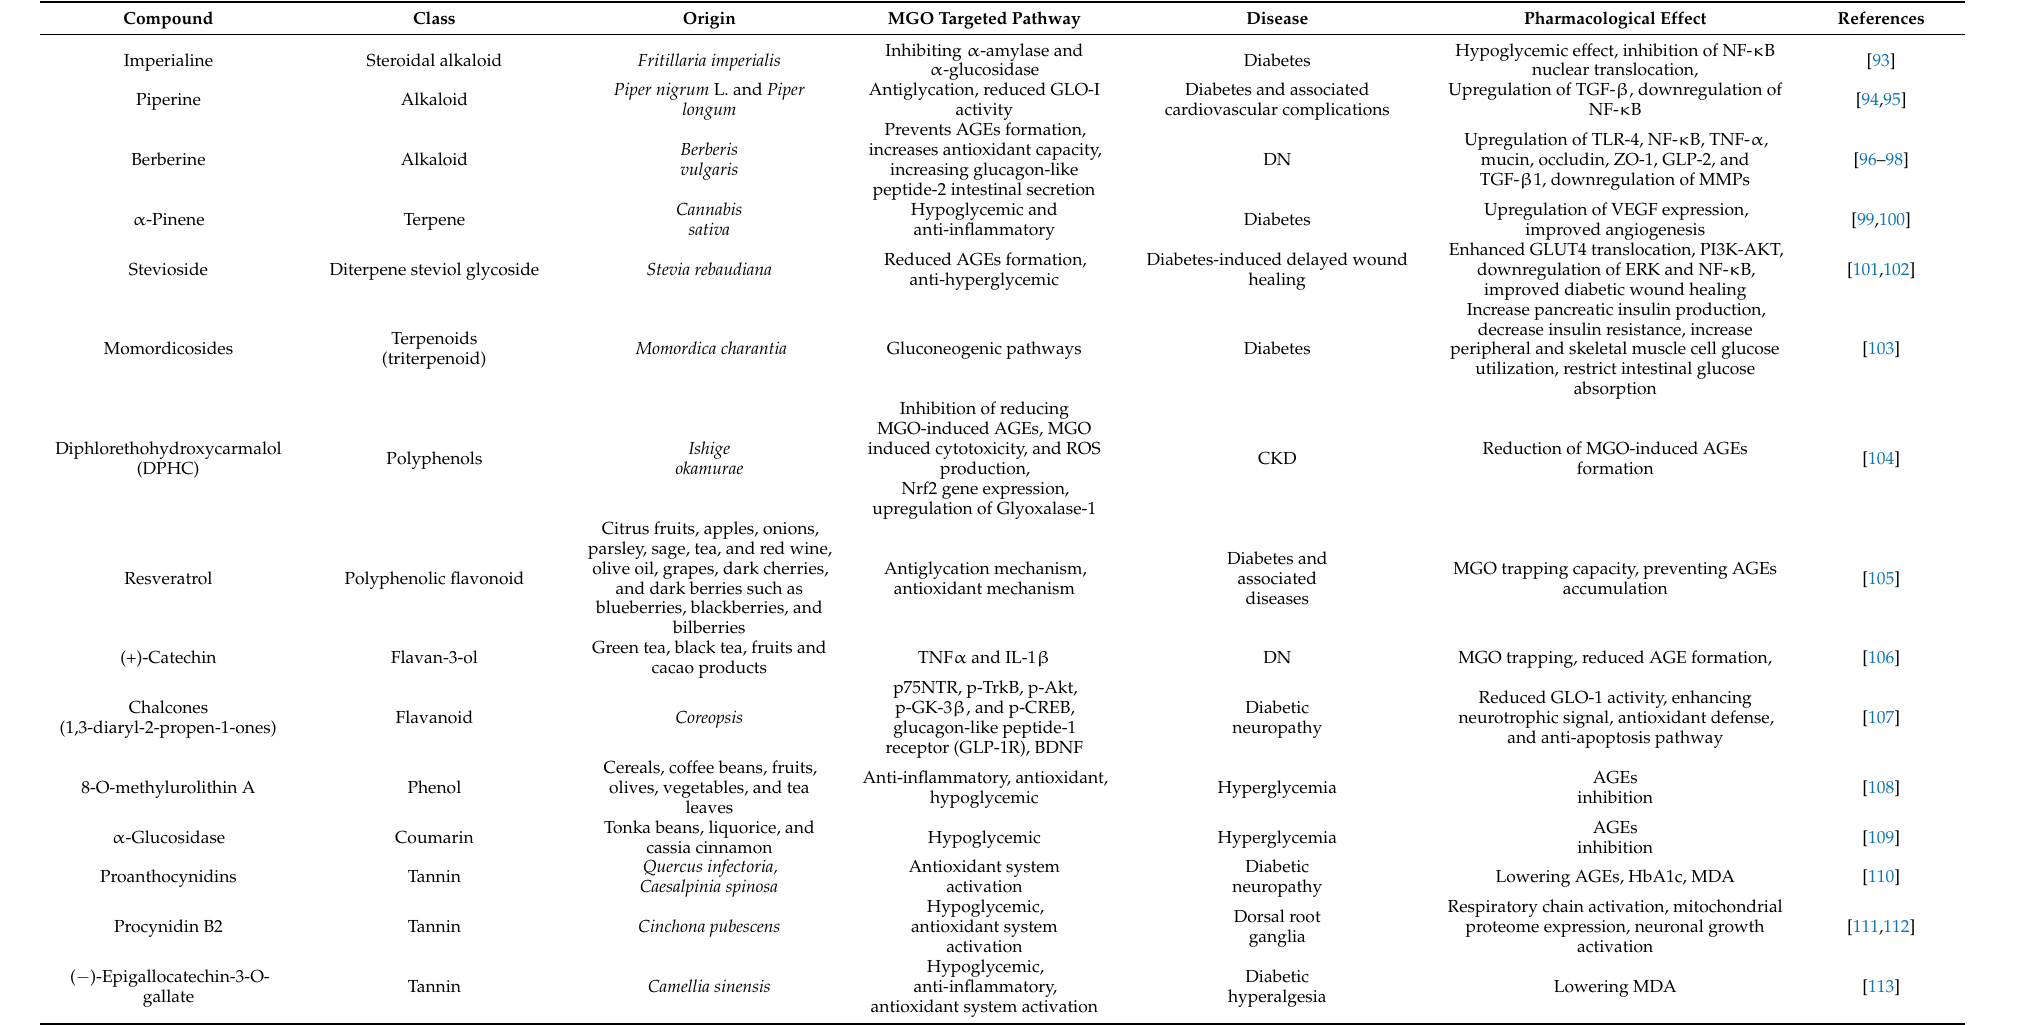
Table 2. Potential phytoconstituents from natural sources that exhibit antiglucotoxicity and antiglycation effects through regulation of various signaling